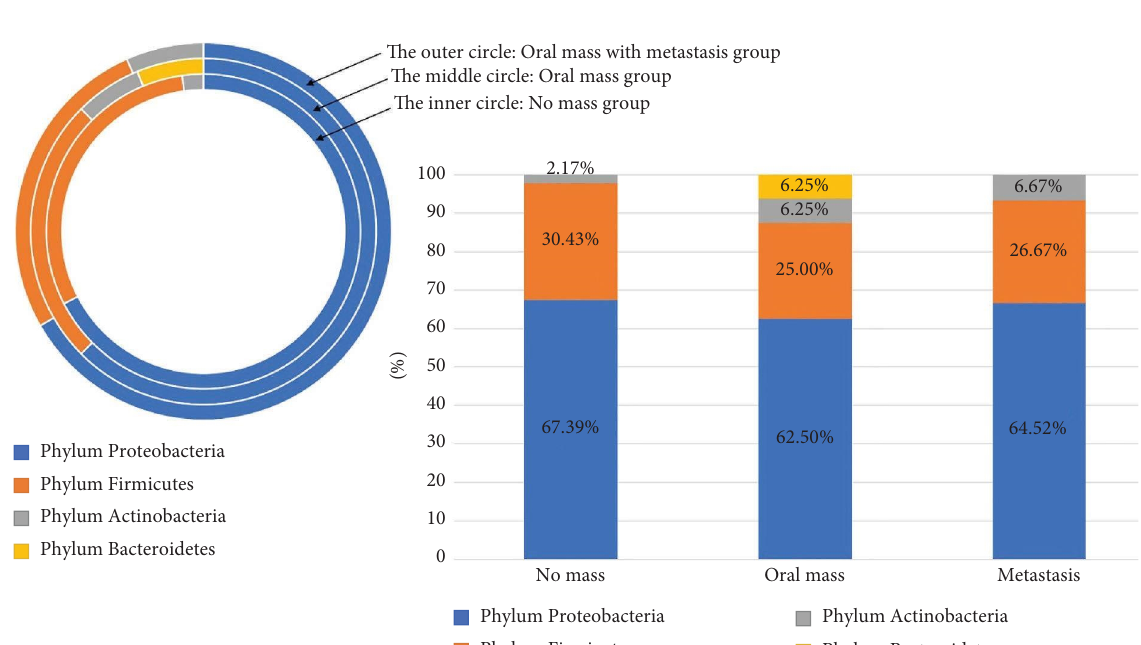
Figure 6: Phylum of the bacterial isolates which were analyzed based on 16S rRNA gene taxonomy from the canine oral swabs in the three groups of